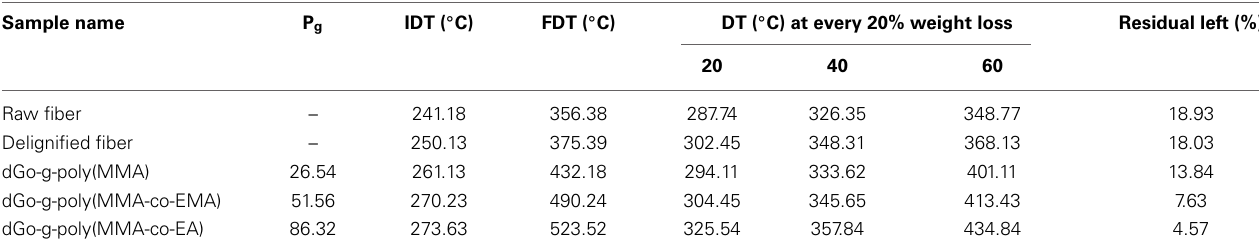
Table 3 | Thermogravimetric analysis of grafted and ungrafted samples.